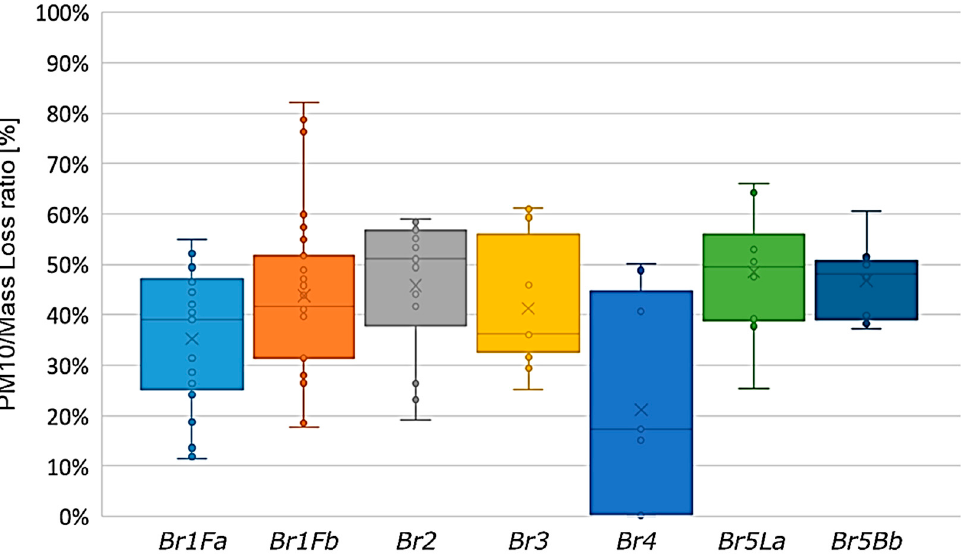
Figure 5. Overview of the PM10 to mass loss ratio for all brakes. The minimum, first quartile, median (denoted with the horizontal line), average (denoted with the “×”), third quartile, and maximum statistical variables are included in the chart. No outliers were detected.